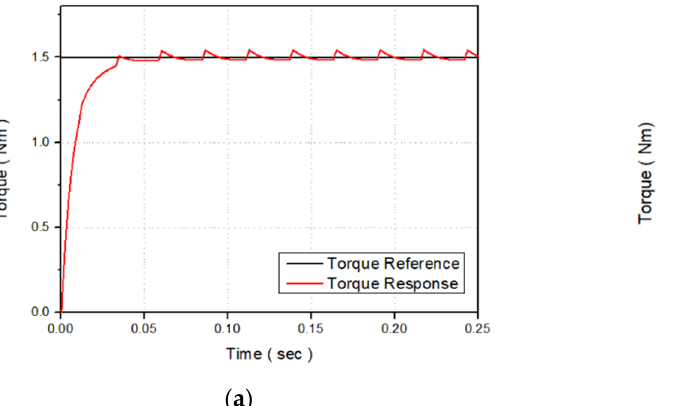
Figure 17. Torque ripple that occurs during DTC torque control. ( a ) Scenario with no compensation for disturbance voltage generated during the dead time ( b ) Scenario when the disturbance voltage generated during the dead time is compensated using a disturbance observer.